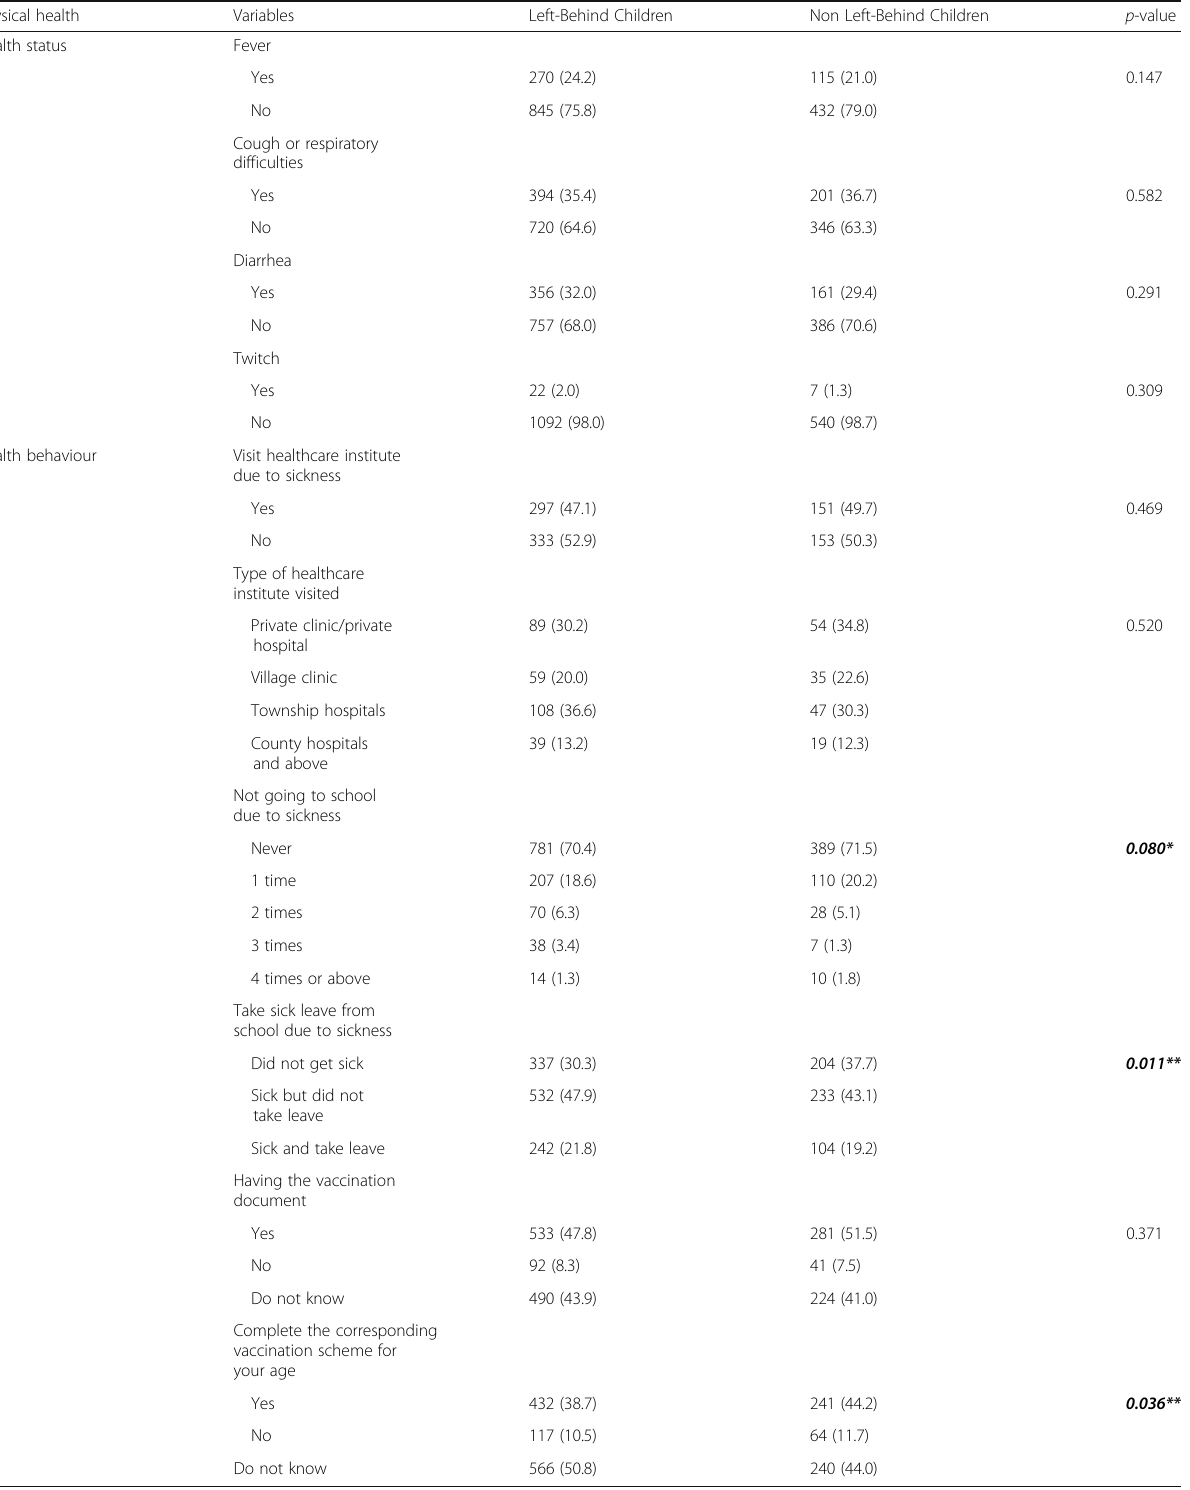
Table 2 Physical health variables of the participants between left-behind children group and non left-behind children group Physical health